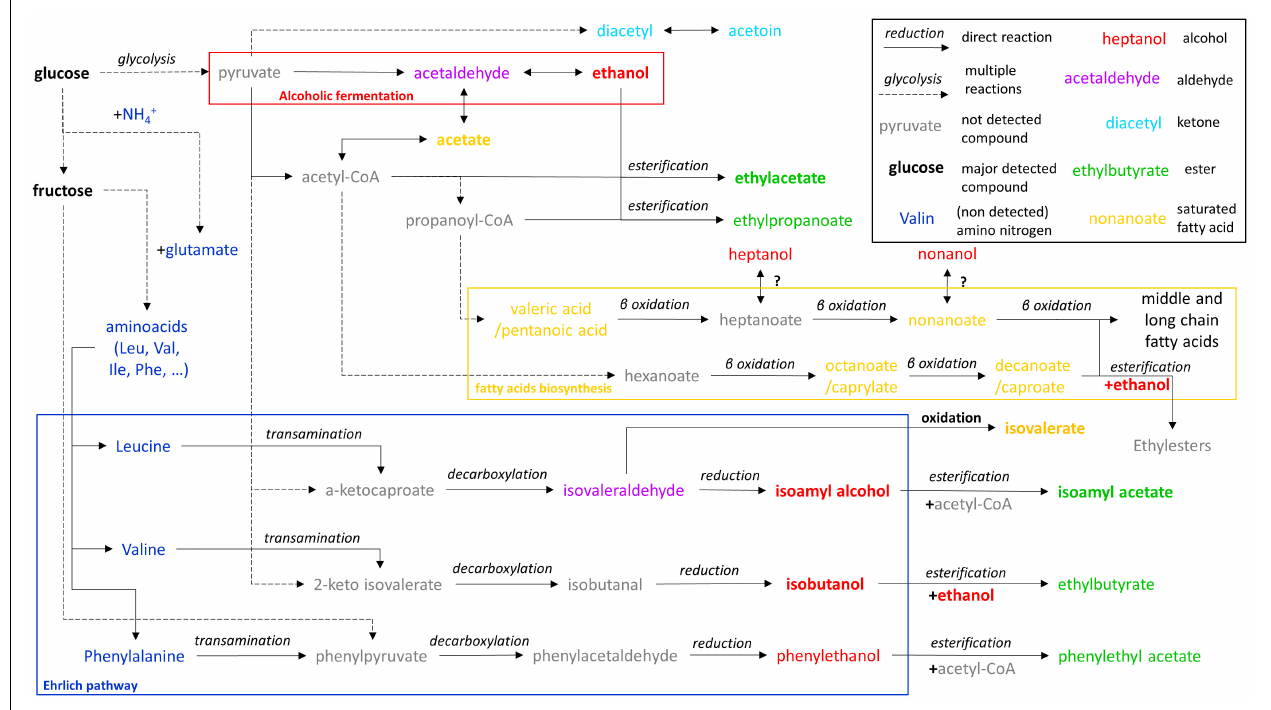
FIGURE 2 | Putative metabolic pathways of fermentative volatile metabolites detected based on S. cerevisiae metabolism (Yoshizawa et al., 1961; Ardö, 2006; Ljungdahl and Daignan-Fornier, 2012; Yu et al., 2016; Belda et al.,